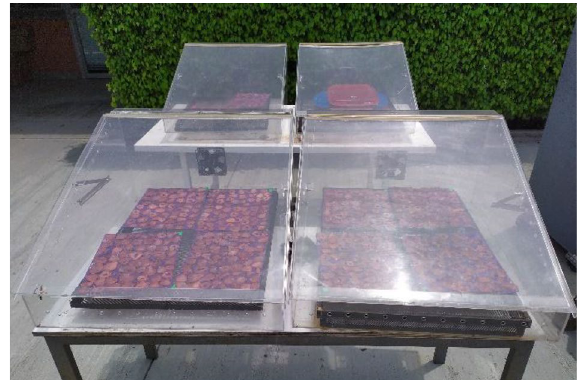
Figure 12. Cabinet-type direct dryer system used in experiments with coated and uncoated strawberry